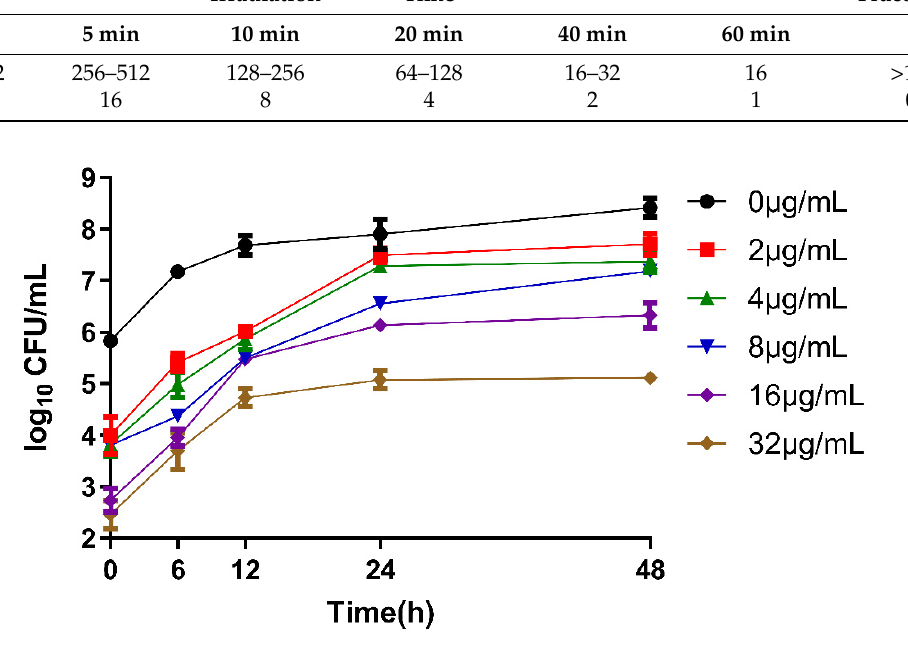
Figure 1. Time–kill curves of EA against C. albicans. Sessile minimum inhibitory concentration (SMIC) was determined for the C. albicans : SMIC 80 was the anticandidal concentration at which an 80% decrease in biofilm OD490 was detected in comparison with the control biofilms formed by the same C. albicans isolate in the absence of anticandidal agent. The minimum inhibitory concentration (MIC) was defined as the lowest concentration of EA that completely inhibited the growth of C. albicans